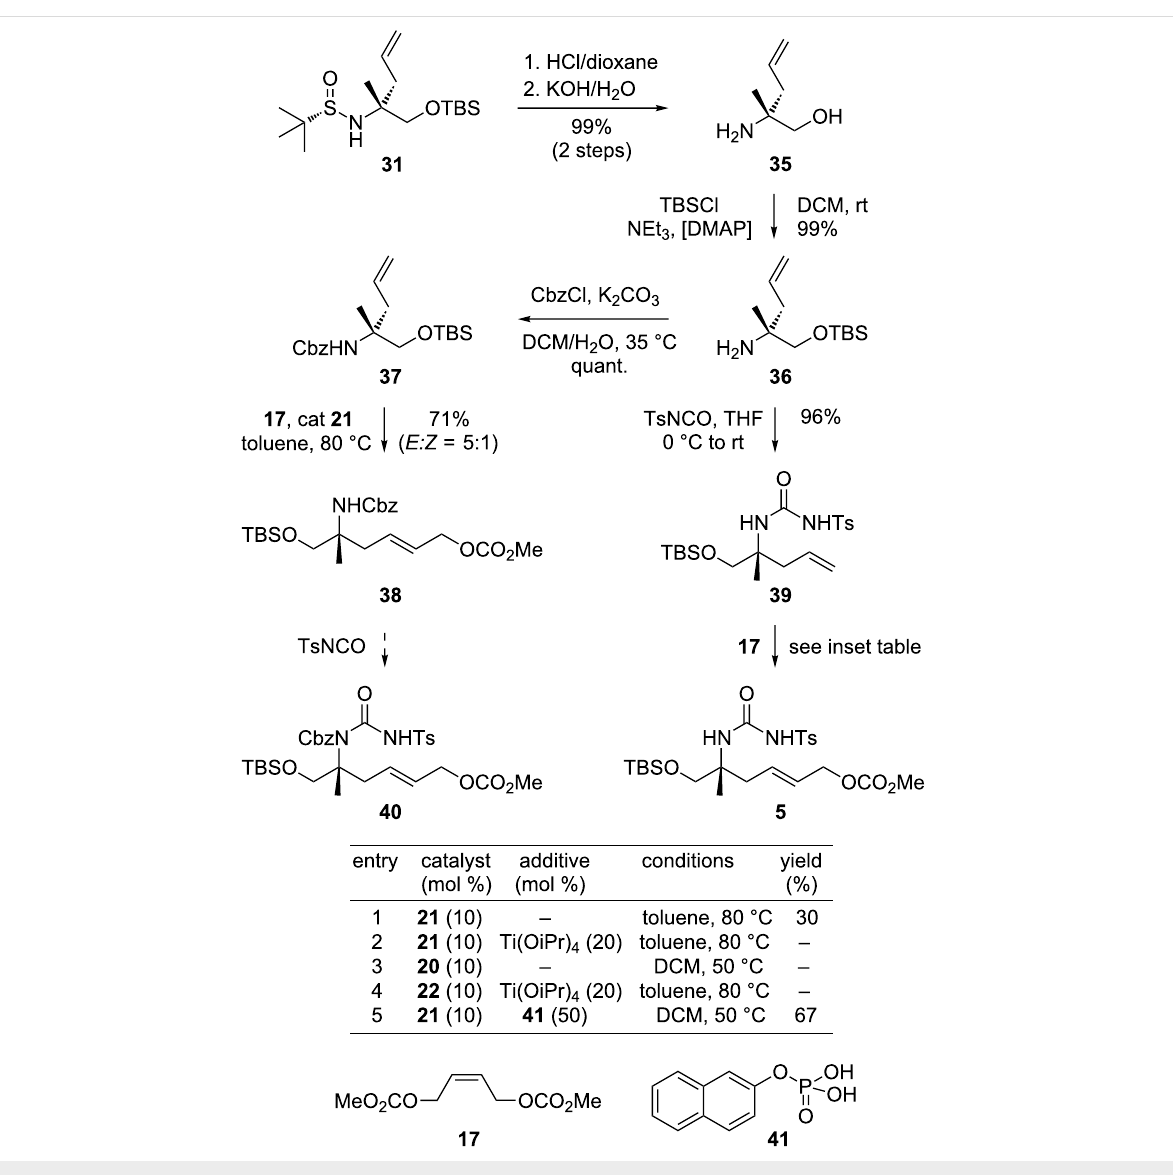
Scheme 6: Synthesis of the authentic cyclization precursor 5